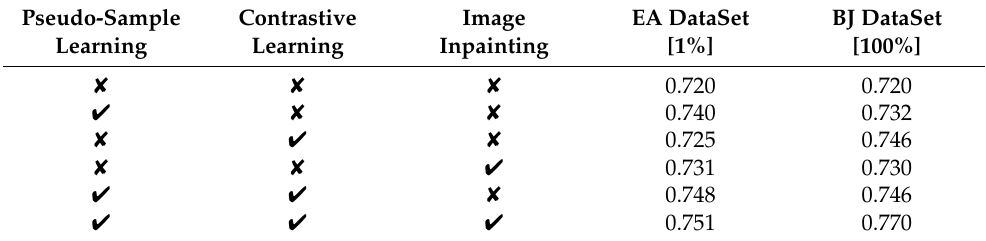
Table 6. Ablation